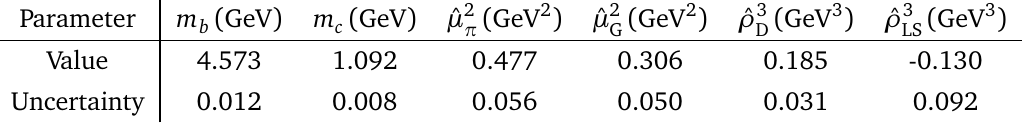
Table 1: Numerical values for the quark masses and non-perturbative parameters, taken from Ref. [ 27 ]